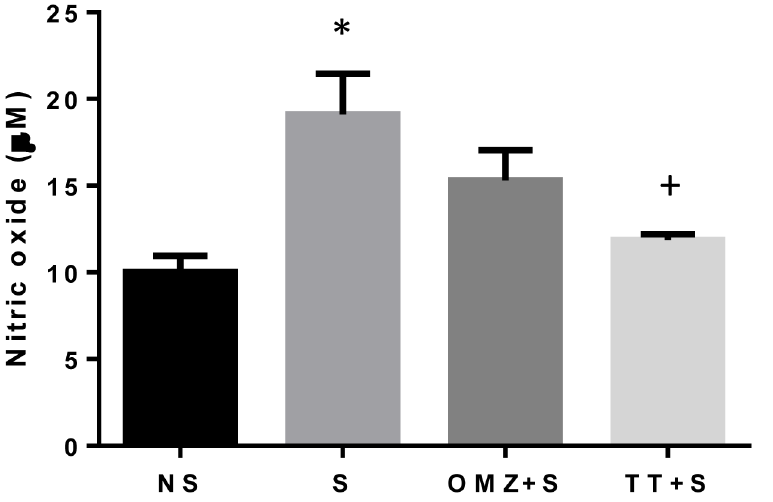
Fig 6. Effects of pre-treatment with tocotrienol (60 mg/kg BW) (TT) or omeprazole (20 mg/kg BW) (OMZ) on gastric nitric oxide (NO) concentration in rats exposed to water immersion restraint stress (n = 7). * vs non-stressed control (NS) (P < 0.05). + vs stressed control (S) (P < 0.05).